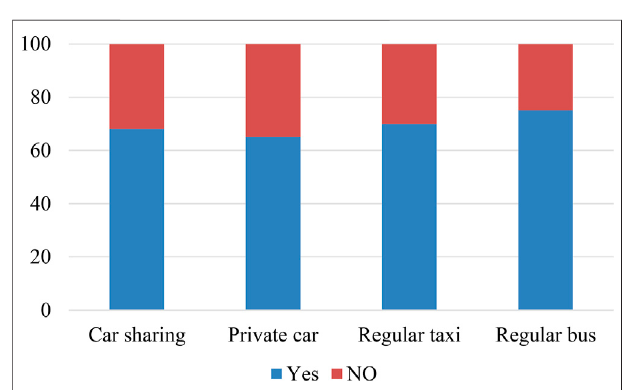
FIGURE 5 | Respondents ’ selection of modes for working